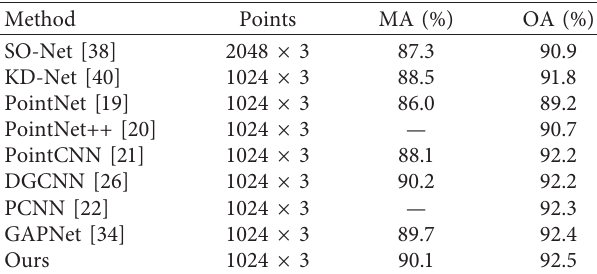
Figure 8: The curves of testing loss and accuracy varying with epochs for ModelNet40. (a) Loss. (b) Accuracy. (c) Mean accuracy. Table 1: Classification results on ModelNet40. MA represents mean per-class accuracy, and the per-class accuracy is the ratio of the number of correct classifications to that of the objects in a class. OA denotes the overall accuracy, which is the ratio of the number of overall correct classifications to that of overall